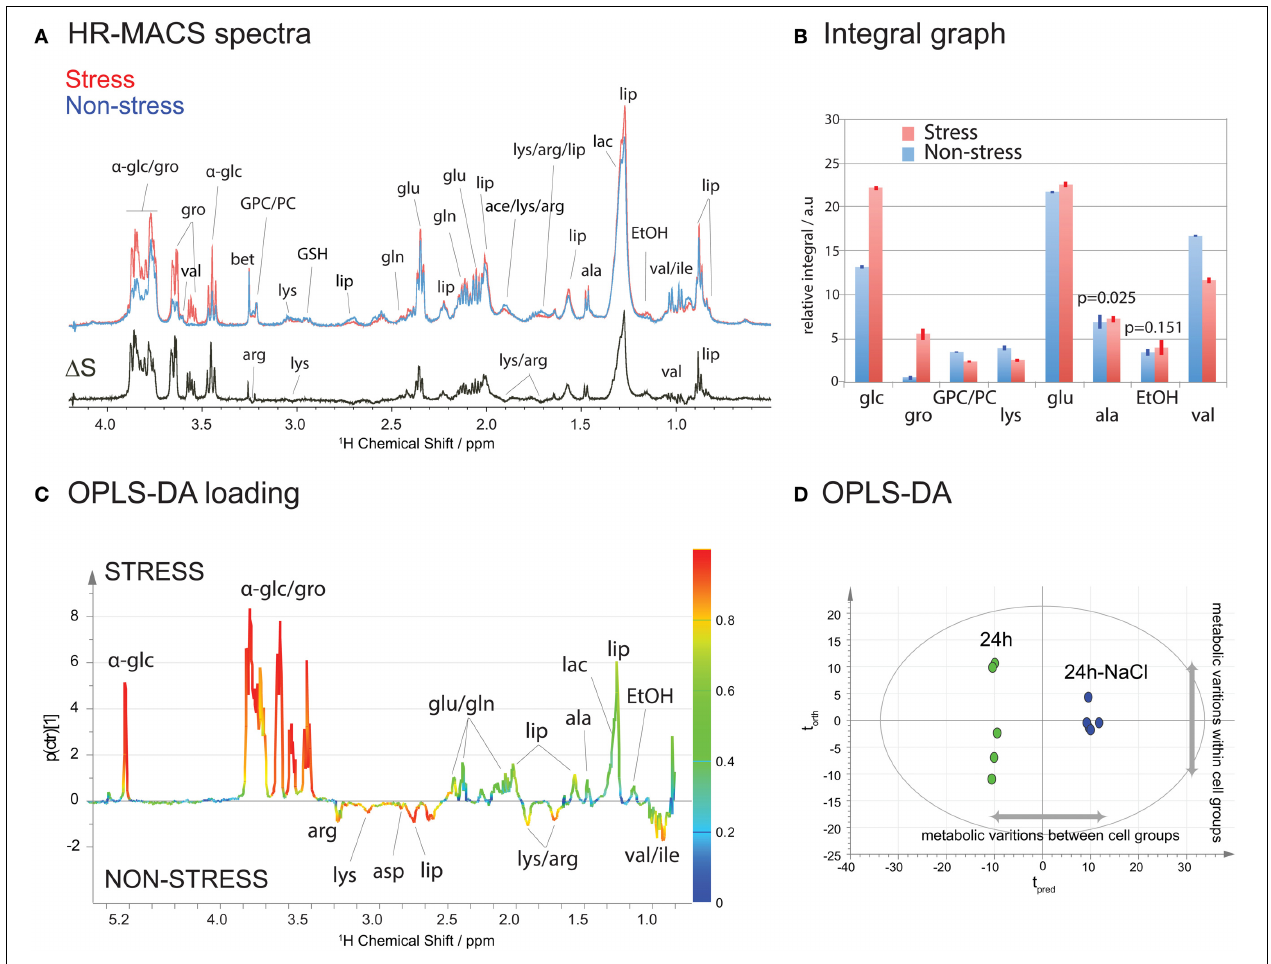
FIGURE 3 | 1 H HR-MACS NMR study of stressed cells. (A) Spectral comparison of averaged spectra ( n = 5): red corresponds to stressed cells and blue to non-stressed cells. The (cid:3) S spectrum is the spectral difference between stressed and non-stressed cells, where the positive peaks correspond to the increased in metabolite contents in stressed cell, and the negative peaks in the non-stressed cells. The assignments including the abbreviations are listed in Table S1 in SI. (B) Bar-graph